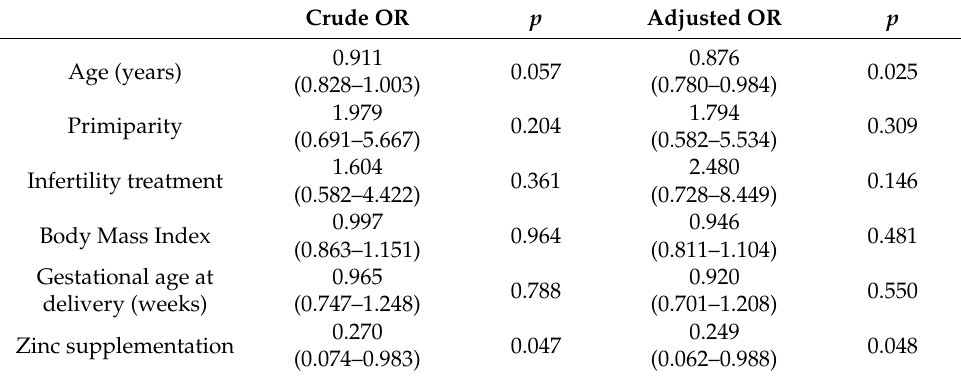
Table 3. Logistic regression analysis for the risk of EPDS ≥